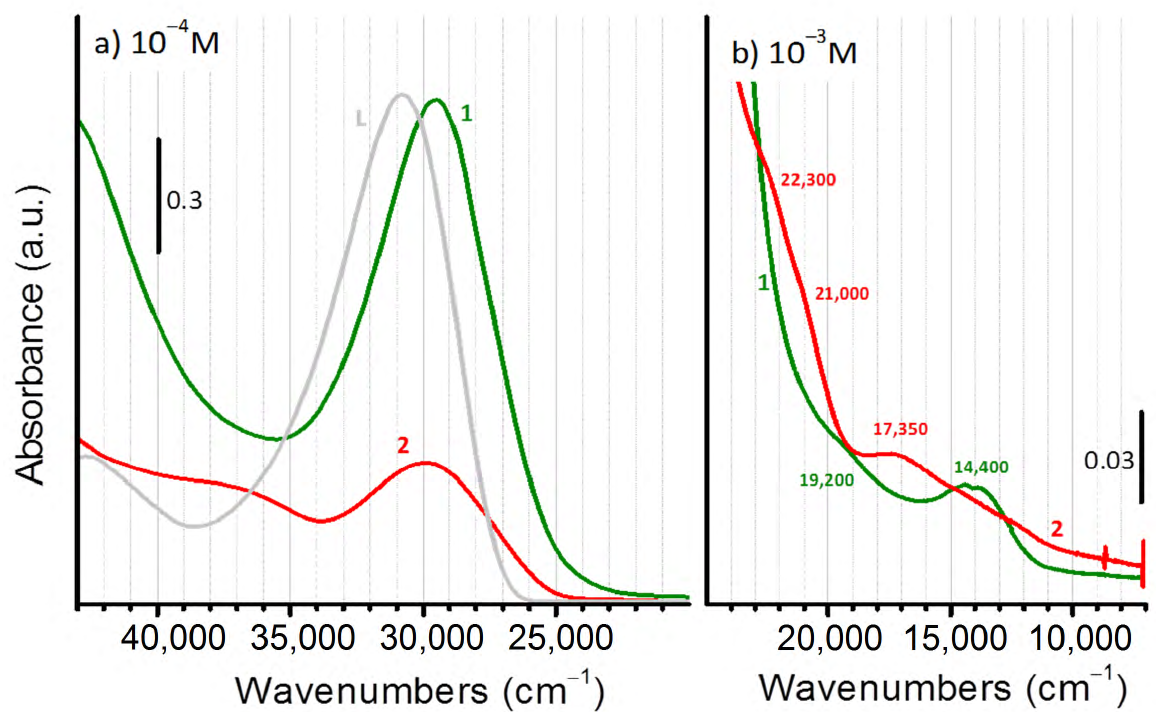
Figure 5. Transmission UV-Vis spectra of complexes 1 (green line) and 2 (red line) in comparison to that of the neutral ligand L (grey line) in the region of intra-ligand π - π * transitions ( a ) and in the region of d-d transitions ( b ). The spectra have been collected in chloroform at the concentration of 10 − 4 M ( a ) and 10 − 3 M ( b ),